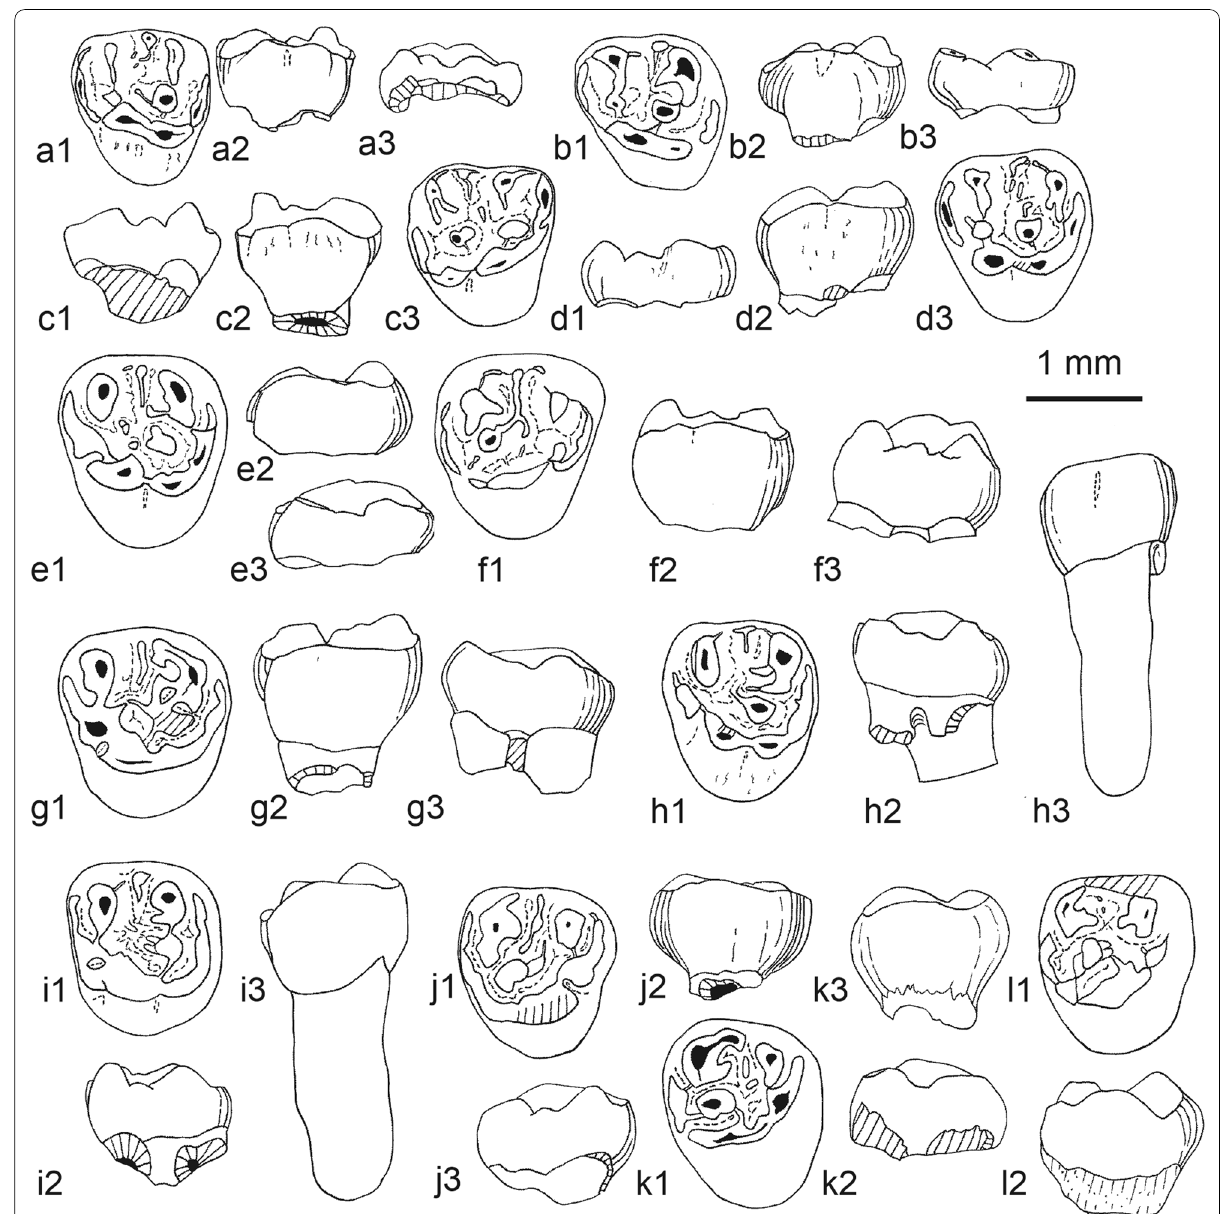
Fig. 29 Upper DP4 and P4 of ? Protadelomys alsaticus Hartenberger, 1969 from Bouxwiller (Bas‑Rhin). a CSBX67‑1 left DP4; a1, occlusal view; a2, lingual aspect; a3, buccal aspect. b CSBX4, left DP4; b1, occlusal view; b2, lingual aspect; b3, buccal aspect. c : CSBX1, left DP4; c1, buccal aspect; c2, lingual aspect; c3, occlusal view. d CSBX27, left DP4; d1, buccal aspect; d2, lingual aspect; occlusal view. e CSBX5 left P4; e1, occlusal view; e2: lingual aspect; e3, buccal aspect. f CSBX6, right P4; f1, occlusal view; f2, lingual aspect; f3, buccal aspect. g CSBX7, left P4; g1, occlusal view; g2, lingual aspect; g3, buccal aspect. h CH48, left DP4; h1, occlusal view; h2, buccal aspect; h3, lingual aspect. i CSBX9, right P4; i1, occlusal view; i2, buccal aspect; i3, lingual aspect. j : CSBX26, right P4; j1, occlusal view; j2, lingual aspect; j3, buccal aspect. : k : CSBX28, right P4; k1, occlusal view; k2, buccal aspect; k3, lingual aspect. l : CSBX29, right P4; l1, occlusal view., l2, lingual aspect. Scale bar: 1